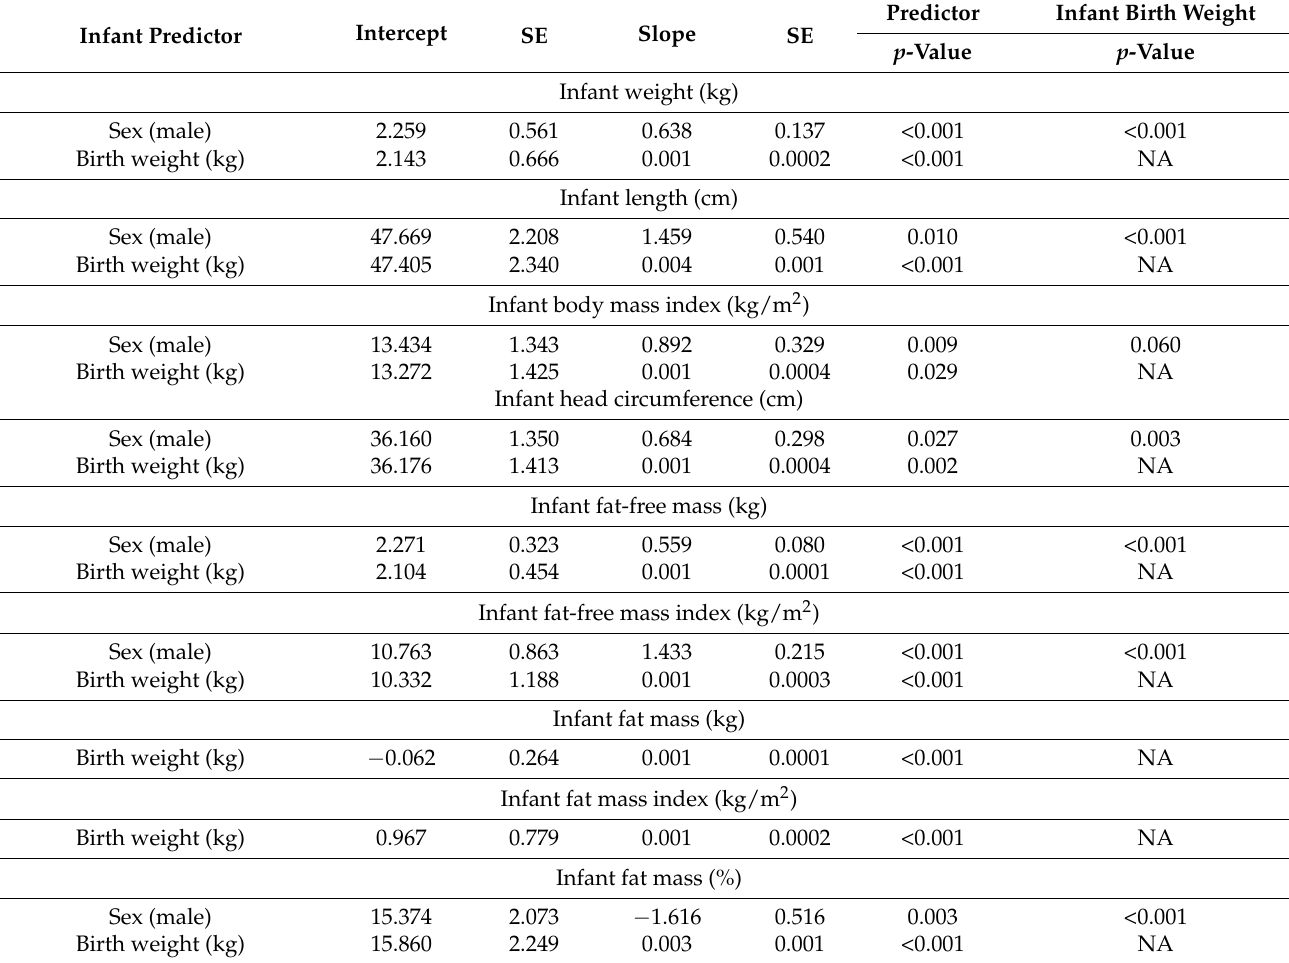
Table A2. Associations between infant characteristics and body composition at 3 months